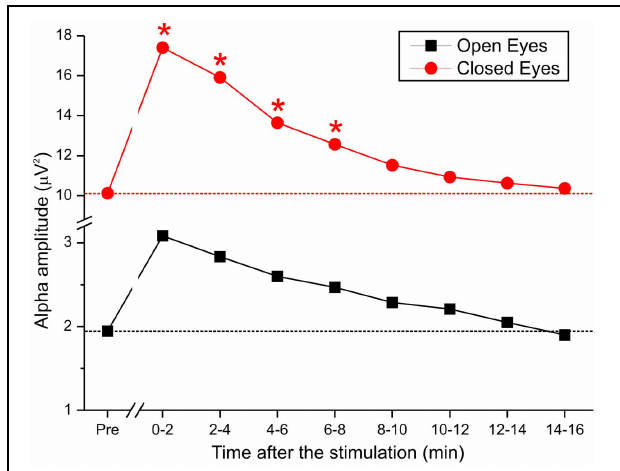
FIGURE 5 | Time course of alpha activity during pretest and after the end of anodal tDCS in 8 epochs of 2min